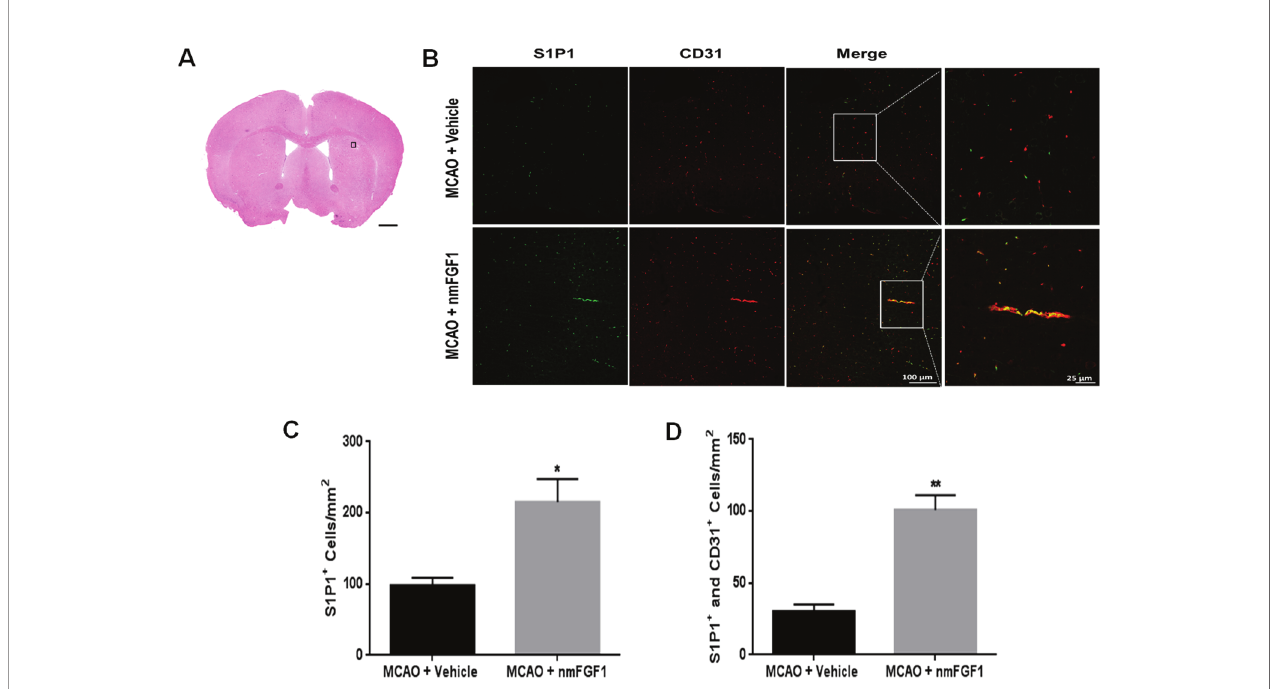
FIGURE 3 | Non-mitogenic fi broblast growth factor 1 (nmFGF1) enhanced angiogenesis in ischemic boundary following ischemia stroke by S1P1 signaling pathway. (A) A representative image of HE staining in a coronal brain section at 10 days after middle cerebral artery occlusion (MCAO). Box illustrates the peri-infarct areas from the corpus callosum where images in B were taken. (B) Representative immuno fl uorescence images showing the co-localization of S1P1 and CD31 at 10 days after stroke. (C) Quantitative analysis of S1P1-positive cells in ischemic boundary following stroke. (D) Quantitative analysis of co-localization of S1P1 and CD31 at 10 days after stroke. Date are means ± SEM (n = 5). *p < 0.05, and **p < 0.01 as compared to the middle cerebral artery occlusion (MCAO) + vehicle